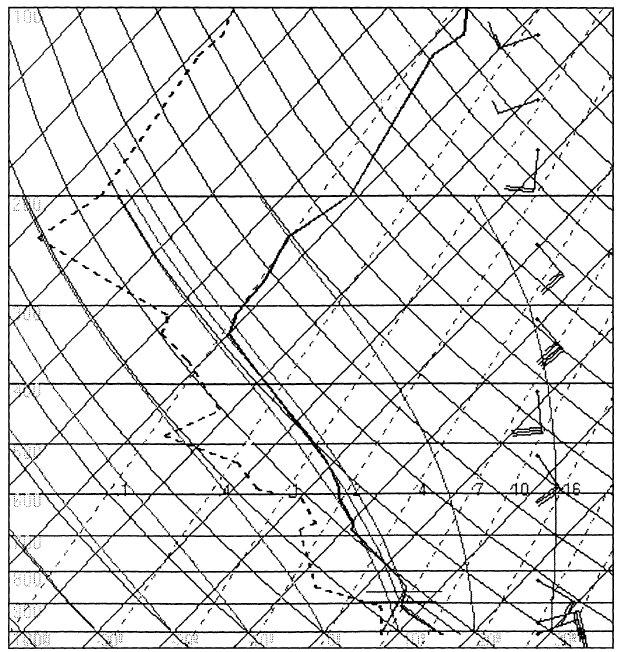
Fig. 5. Same as Fig. 4. but for 31 January 1993 at